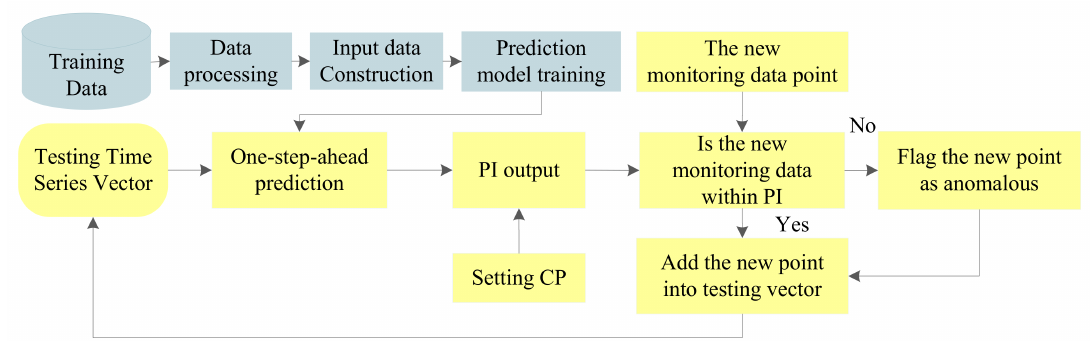
Figure 1. Anomaly detection based on prediction interval (PI).